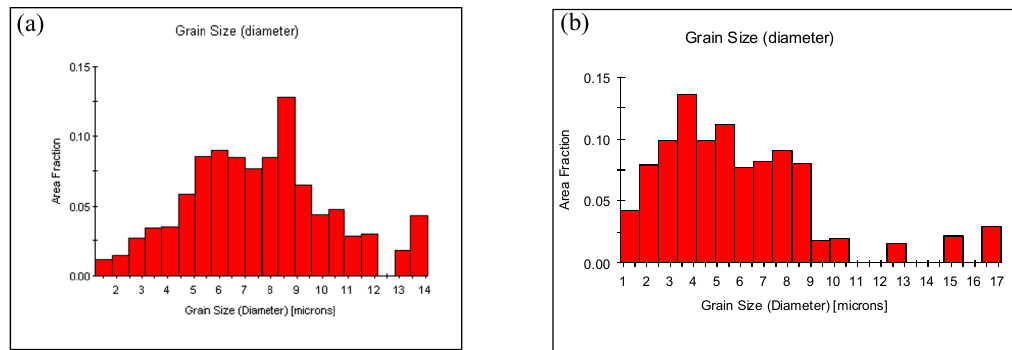
Figure 1. Microstructures of the forged alloy and extruded alloy. ( a , b ) optical microscope (OM) microstructure and scanning electron microscope (SEM) image of the forged alloy, ( c ) and ( d ) OM microstructure of the transverse section and SEM image of the extruded alloy.